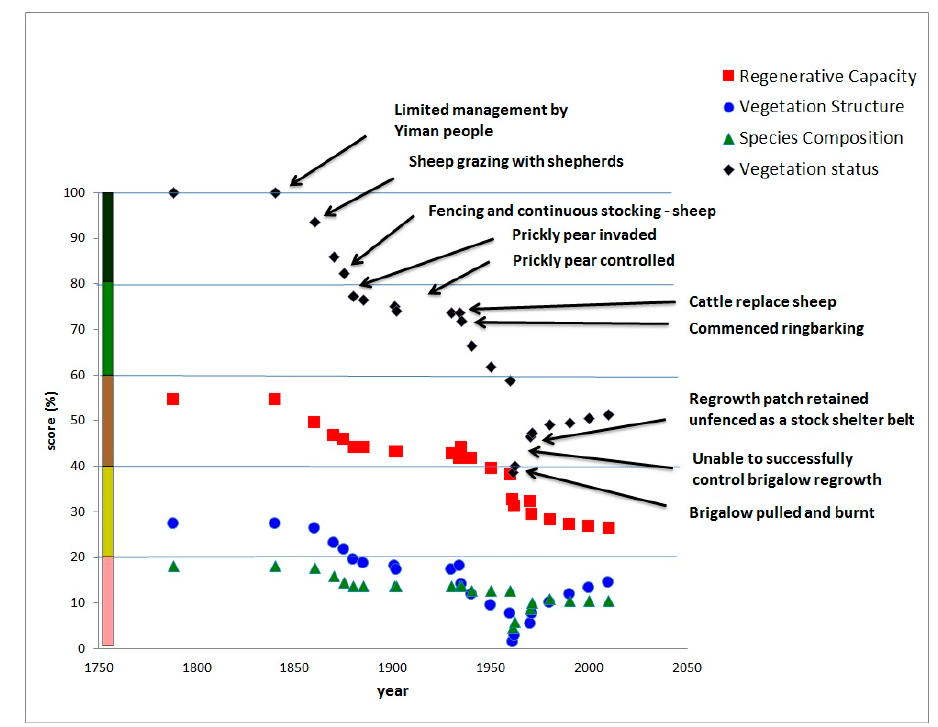
Figure 5. Case study 4: Winona, Gulgong, temperate, sub-humid agro-climate region, tussock grassland, eucalypt open woodland. Land 2016 , 5 , 40